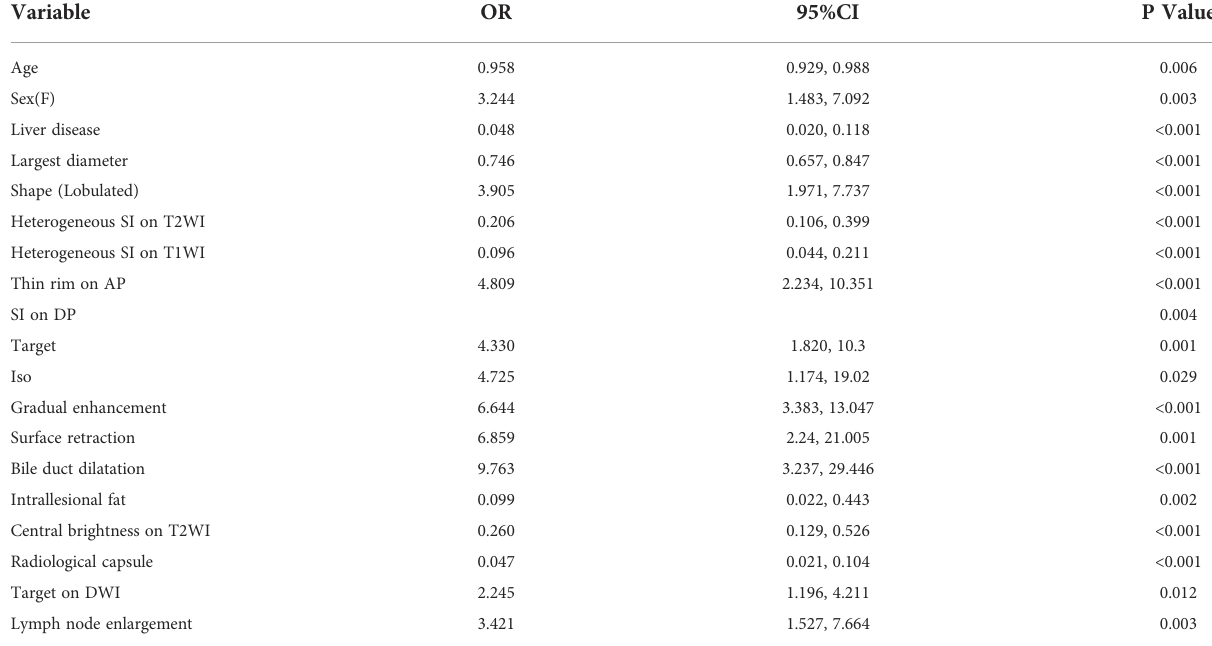
TABLE 3 Univariate analysis for distinguishing HCCs from IMCCs.